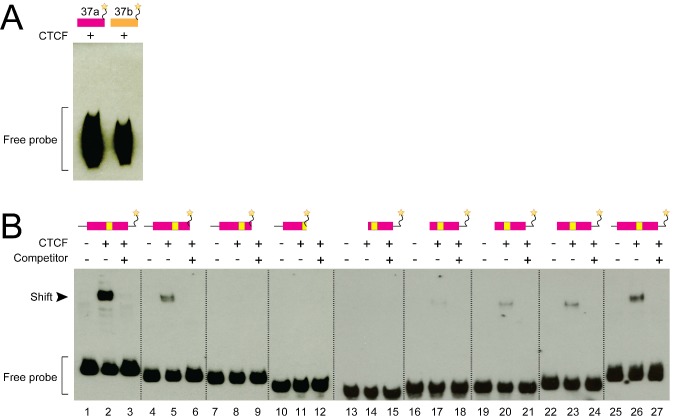
CTCF does not bind RNA Cacna1b e37a and CTCF binding to DNA Cacna1b e37a in vitro increases with probe length.(A) RNA gel shift assay for Cacna1b probes (97 bp) containing e37a or e37b with 50 ng recombinant CTCF. (B) DNA gel shift assay for different length e37a Cacna1b DNA probes. Full length, 3’ truncated, and 5’ truncated DNA probes containing e37a either alone (lanes 1, 4, 7, 10, 13, 16, 19, 22 and 25) or preincubated with 50 ng recombinant CTCF (lanes 2, 5, 8, 11, 14, 17, 20, 23 and 26), or CTCF plus 1000-fold excess unlabeled e37a competitor (lanes 3, 6, 9, 12, 15, 18, 21, 24 and 27). Cacna1b probes containing e37a (purple) and CTCF binding motif (yellow) are shown. 3’ truncated DNA probes are shown in lanes 4 to 12, and 5’ truncated DNA probes in lanes 13 to 27.